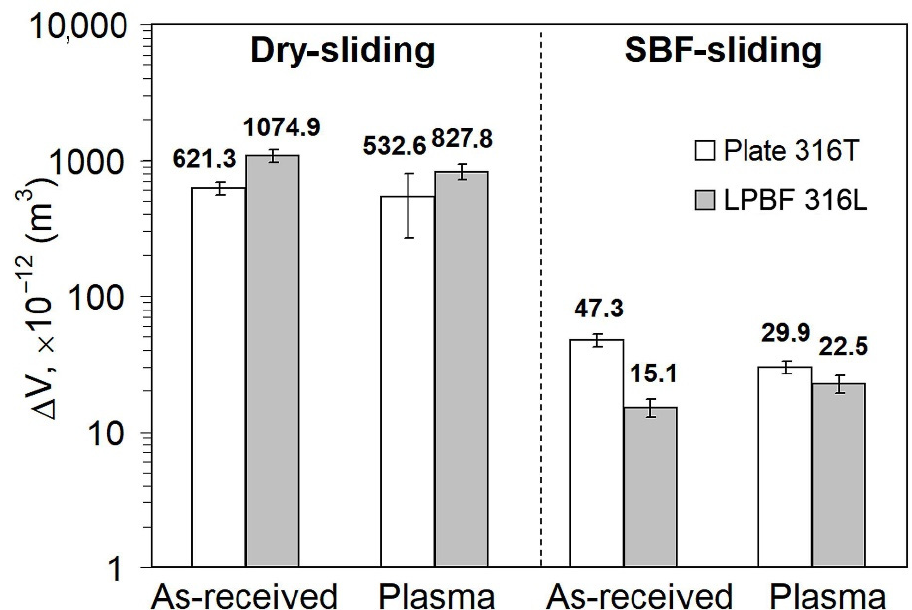
Figure 11. Wear of a plate 316T and LPBF 316L after sliding tests.